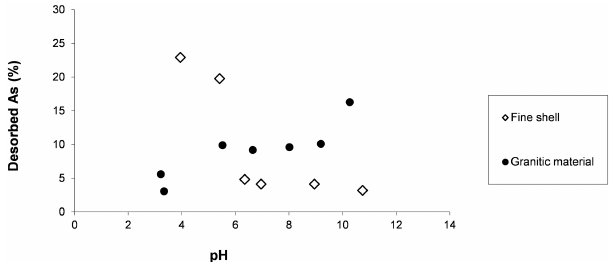
Figure 4. Relationship between As(V) desorption (%) and pH value for fine shell and for the granitic material (average values for three replicates, with coefficients of variation always < 5%) when 100mgL − 1 As(V) were added to the